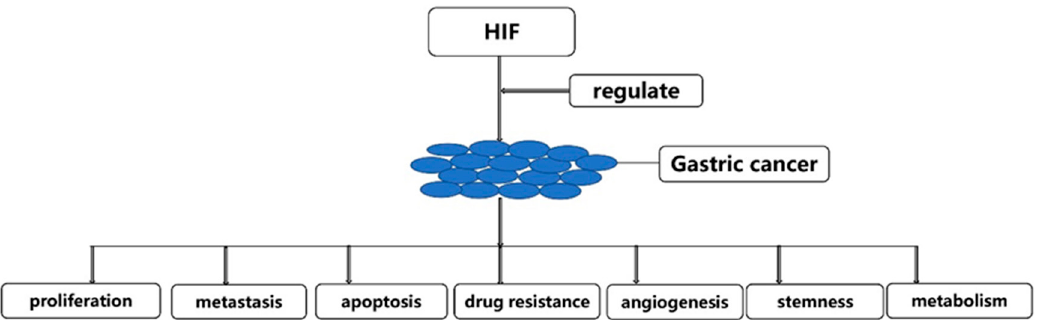
Figure 3. HIF could regulate the occurrence and development of gastric cancer.